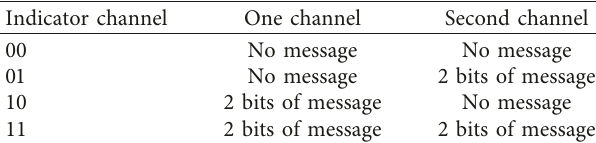
Table 1: Pixel indicator